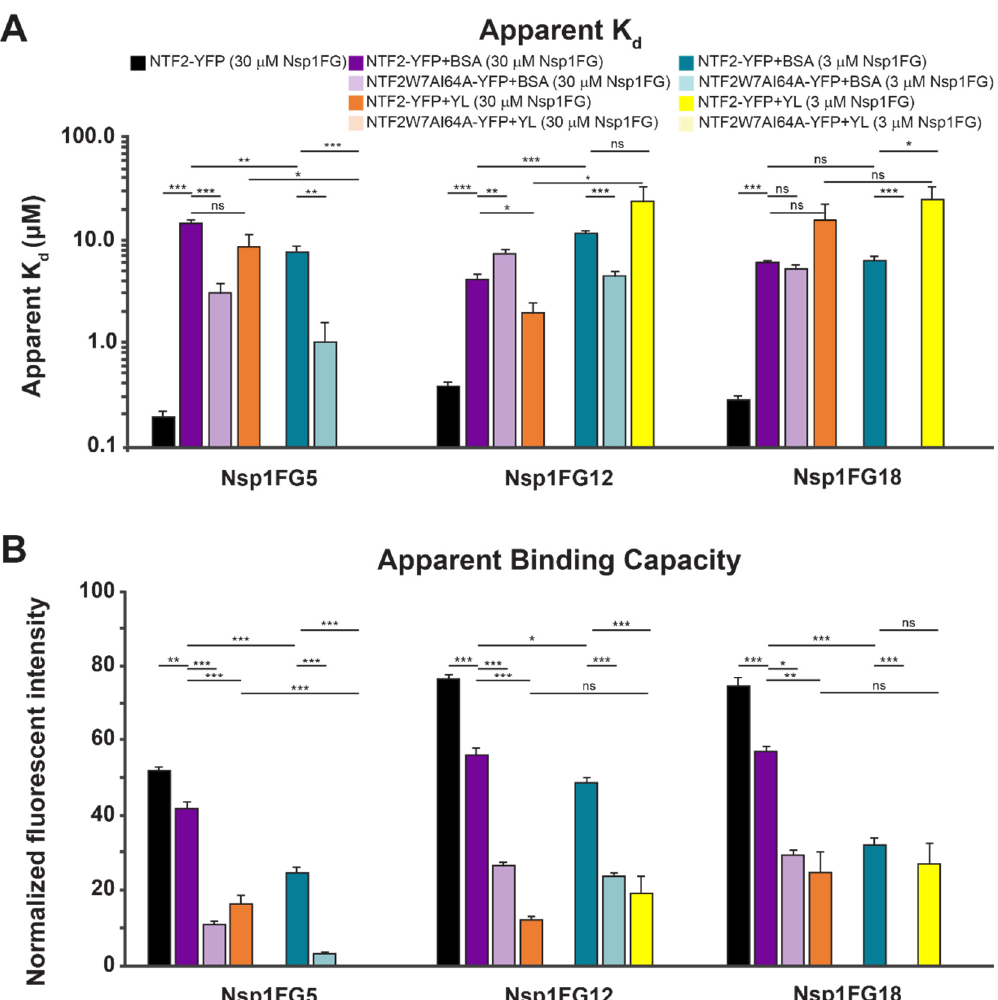
Figure 3. NTF2-YFP apparent K d and binding capacity on Nsp1FG surfaces. ( A ) The apparent K d of NTF2-YFP and NTF2W7AI64A-YFP for Nsp1FG surfaces. ( B ) The apparent binding capacity of NTF2-YFP and NTF2W7AI64A-YFP for Nsp1FG surfaces. In all cases, error bars represent SEM. ns = not significant ( p -value > 0.05), * = p -value 0.05–0.001, ** = p -value 0.001–0.00001, *** = p -value < 0.00001. p -values are detailed in Table